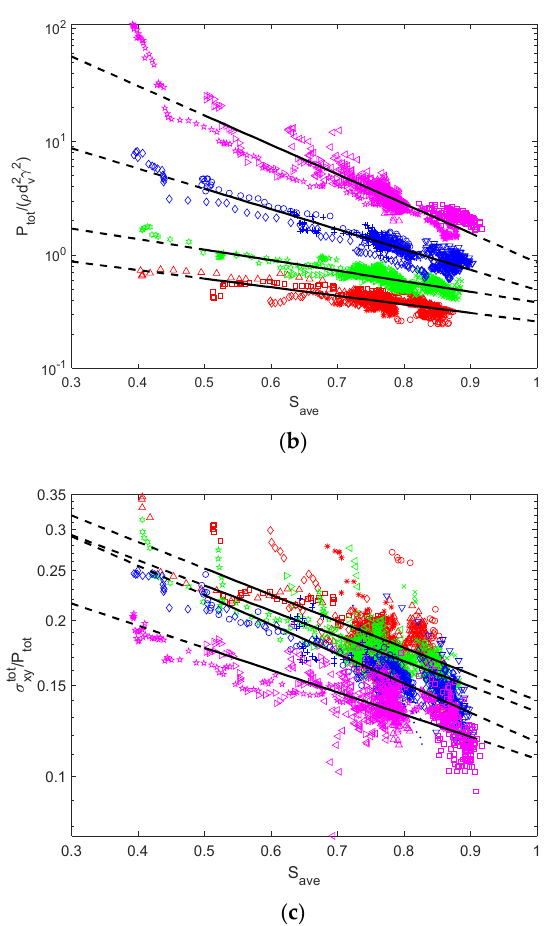
Figure 17. Variation of ( a ) normalized shear stress, ( b ) normalized pressure, and ( c ) ratio of shear stress to pressure with average order parameter S ave for the binary mixtures ( AR = 0.15 and AR = 6) at various solid volume fractions ν . It is noted that the vertical coordinate is the logarithmic coordinate. Thus, the stresses have the exponential dependence on S ave for various ν . Table 3. Coefficients in Equation (24).